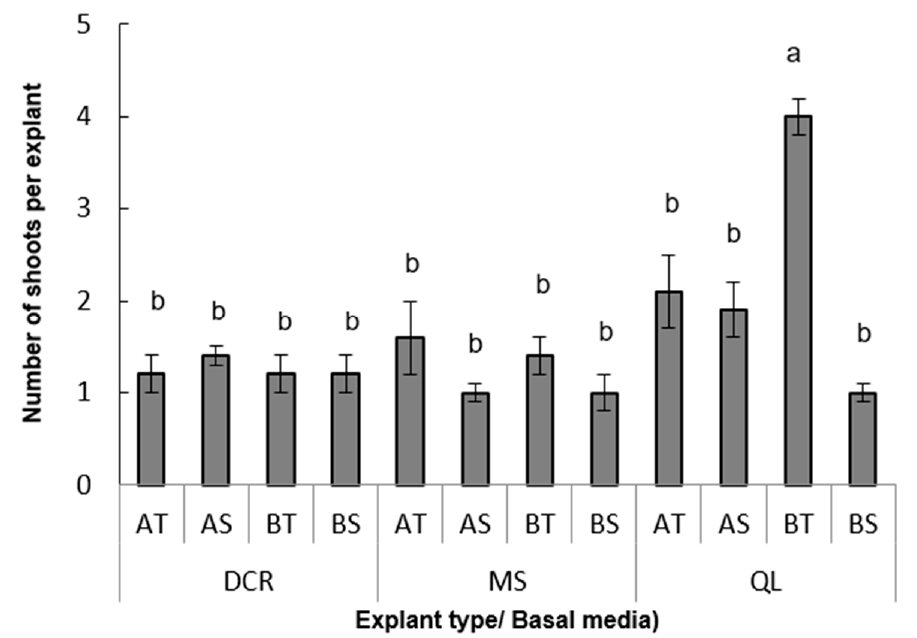
Figure 4. Number of shoots per explant in different explant types of Cryptomeria japonica cultured in DCR medium [13], MS medium [14], and QL medium [15] supplemented with 6-benzyladenine (BA, 8.8 µ M). Apical explants > 1.5 cm (AT), apical explants < 1.0 cm (AS), basal explants > 1.5 cm (BT), and basal explants < 1.0 cm (BS). Data are presented as mean values ± S.E. Significant differences are indicated by different letters according to Tukey’s post hoc test ( p < 0.05).